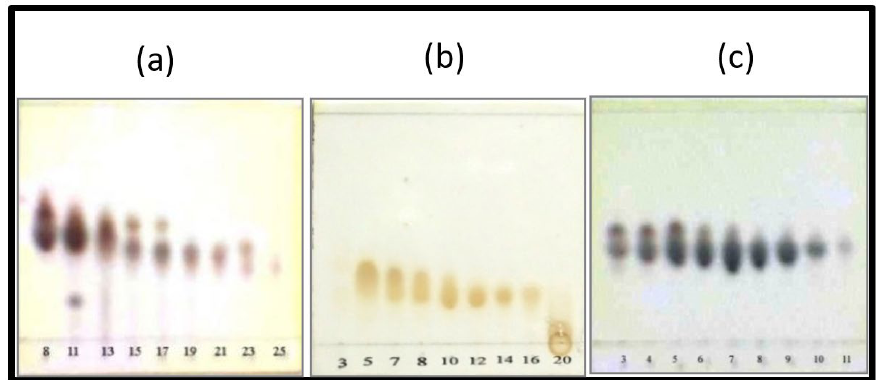
Fig. 3. Profiles of TLC chromatogram of recolumn fractions; (a) Fraction D : eluent n-hexane : ethyl acetate 75%, (b) Fraction D8 : eluent n-hexane : ethyl acetate 87,5%, (c) Fraction D8.3 : eluent n-hexane : ethyl acetate 80%.